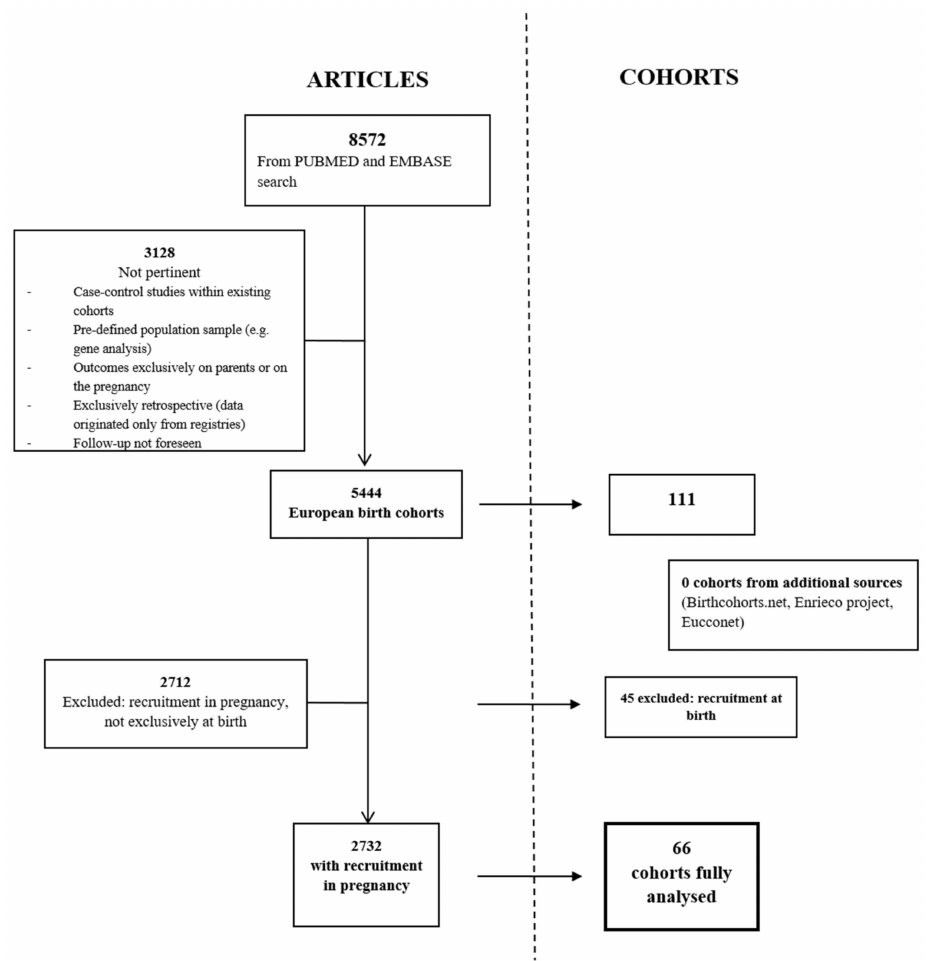
Figure 1. Selection of articles and number of related cohorts. The left panel represent the bibliographic source while on the right panel of the figure the process of cohort selection was